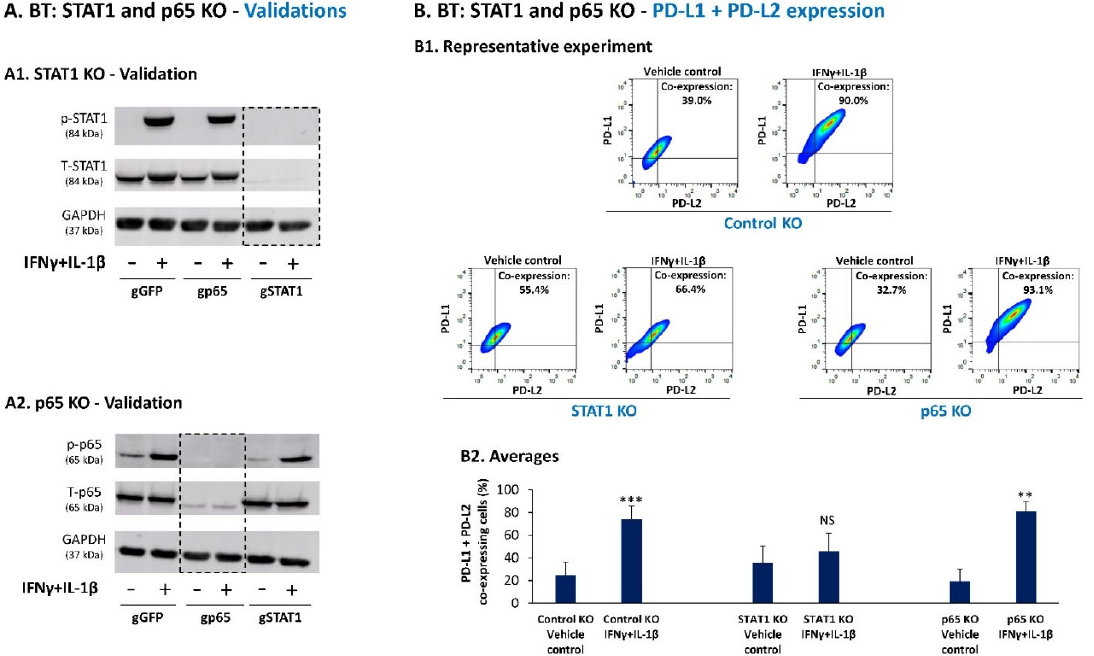
Figure 5. Stimulation of BT ‐ 549 cells by IFN γ + IL ‐ 1 β leads to elevated proportion of PD ‐ L1 + PD ‐ L2 co ‐ expressing cells by activation of STAT1, with no involvement of p65 activation. ( A ) Validation of STAT1 knockout (KO) ( A1 ) and p65 KO ( A2 ) by CRISPR ‐ Cas9 in BT ‐ 549 cells (BT). Activation of STAT1 and of p65 was determined by WB following 30 min stimulation with IFN γ + IL ‐ 1 β (concentrations as in Figure 2), or in cells treated by the vehicle of cytokines. gGFP, Control KO cells undergoing the CRISPR ‐ Cas9 process with a non ‐ relevant sequence; gSTAT1, Cells in which STAT1 was KO; gp65, Cells in which p65 was KO. In each panel, a representative experiment of n = 3 is presented. ( B ) BT cells were stimulated by IFN γ + IL ‐ 1 β or by the vehicle of the cytokines (conditions as in Figure 2), and the proportion of PD ‐ L1 + PD ‐ L2 co ‐ expressing BT cells was determined by flow cytometry (as described in Figure 1B). ( B1 ) A representative experiment of n = 3 is presented. ( B2 ) Average ± SD of n = 3 experiments is presented. *** p < 0.001, ** p < 0.01. NS, Not significant. Figures S2 and S3 present data on PD ‐ L1 and PD ‐ L2 expression levels (MFI) (single staining) following stimulation by each cytokine alone and together, which are complimentary to data on PD ‐ L1 + PD ‐ L2 ‐ co ‐ expresing cells in Figure 5B. Statistical analyses were performed as described in Section 2.